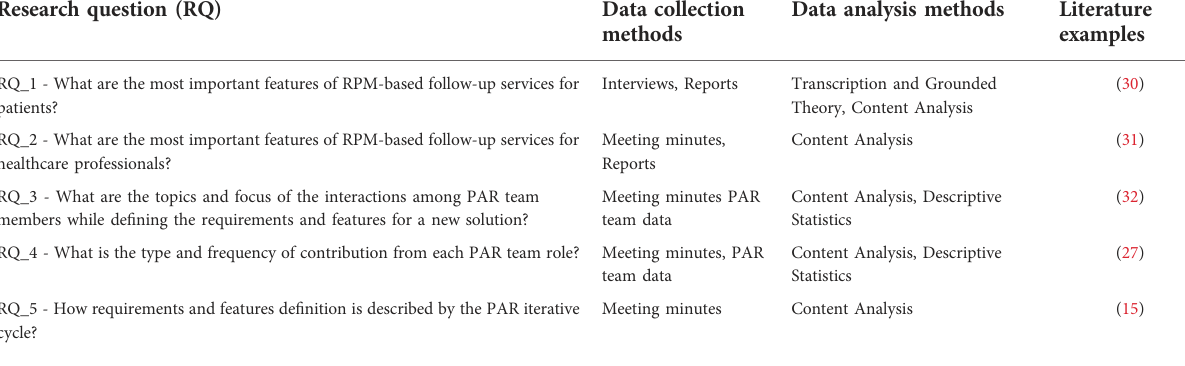
TABLE 1 Research questions and the respective data collection and analysis